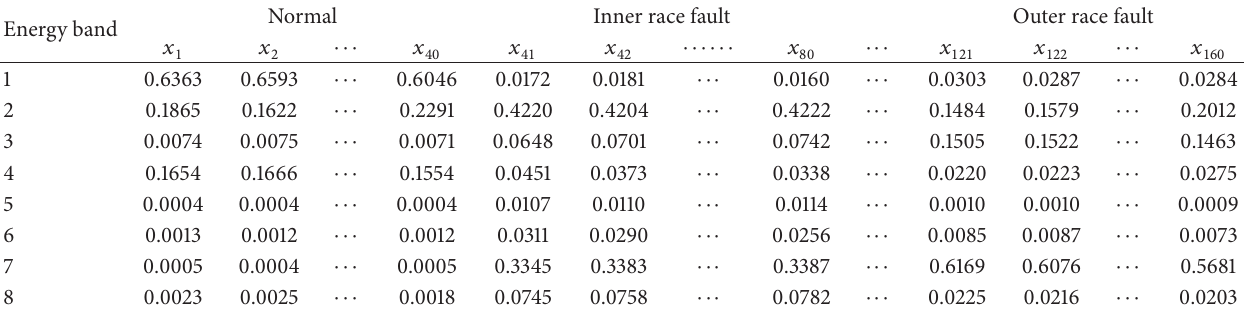
Table 2: Original features constructed by wavelet packet energy spectrums of rolling bear dataset1.